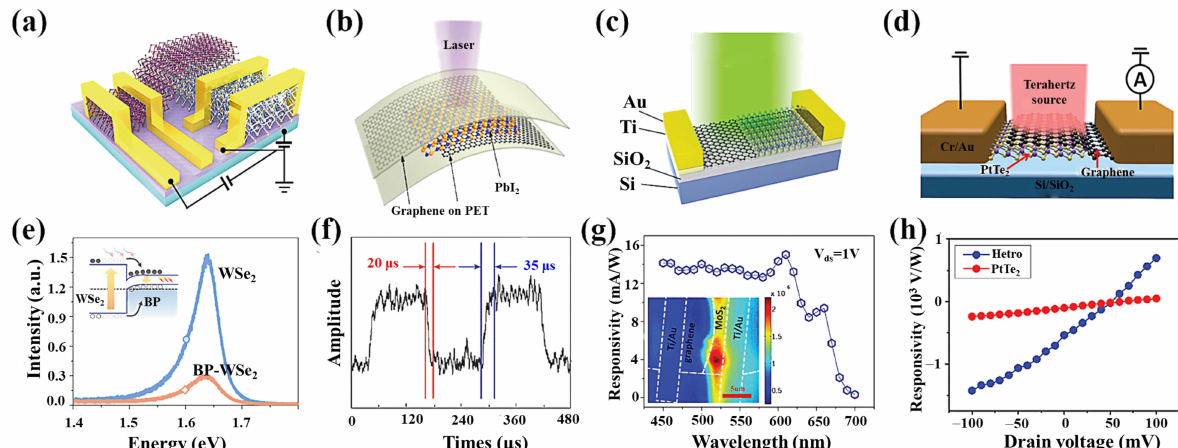
Figure 9. Heterostructure photodetector. ( a ) BP–WSe 2 heterostructures schematic. Schematic band diagram of BP–WSe 2 heterostructures. ( b ) schematic of photoelectric measurement of the flexible device with near-ultraviolet laser source. ( c ) Schematic of lateral graphene–MoS 2 heterostructure Schottky photodetector under the illumination. ( d ) Schematic representation of the electrical configuration for the bow-tie-type PtTe 2 -based THz detector. ( e ) PL spectra of monolayer WSe 2 and the BP–WSe 2 heterostructure under an incident laser. Inset: Schematic band diagram of BP–WSe 2 heterostructures. The dashed line denotes the Fermi energy of BP and WSe 2 . ( f ) Fast device photoresponse, giving the rise and decay time, respectively. ( g ) Spectral responsivity for the detector. The absorption for the light of the device is mainly limited to the bandwidth of MoS 2 , corresponding to the test in the inset. Inset: scanning photocurrent mapping of the detector. ( h ) The voltage responsivity of the two devices under different biases at 0.12 THz. ( a , e ) reproduced with permission from [10]. Copyright Nature Publishing Group, 2019. ( b – d , f – h ) reproduced with permission from [94,98,102]. Copyright Wiley,